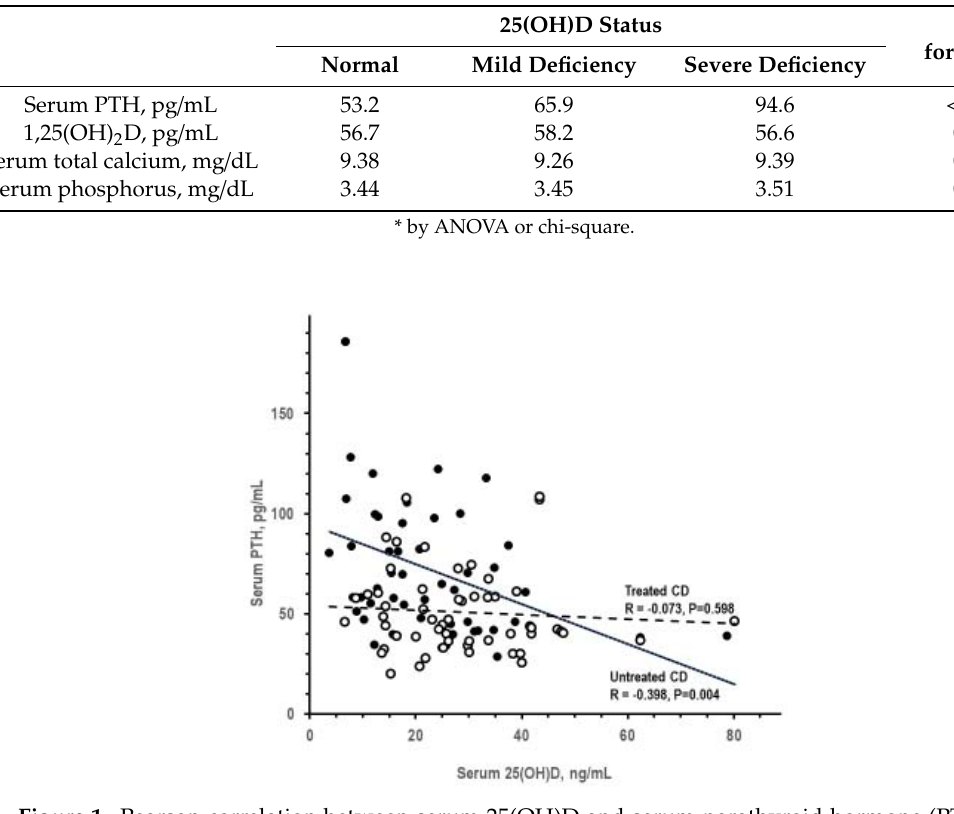
Figure 1. Pearson correlation between serum 25(OH)D and serum parathyroid hormone (PTH) in untreated CeD and treated CeD (closed and open symbols, respectively).